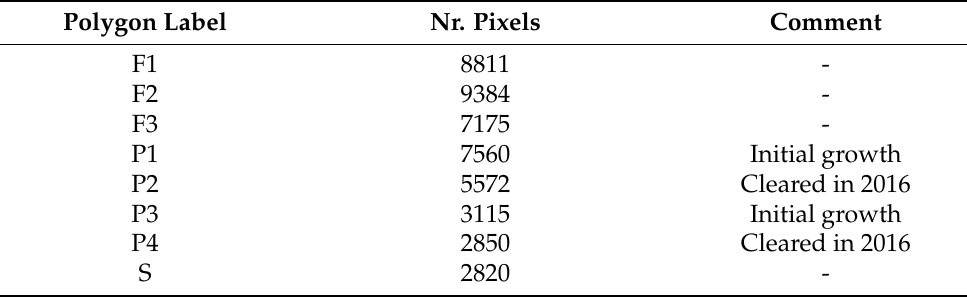
Table 4. Number of pixels contained in each polygon considered for this study. Polygon